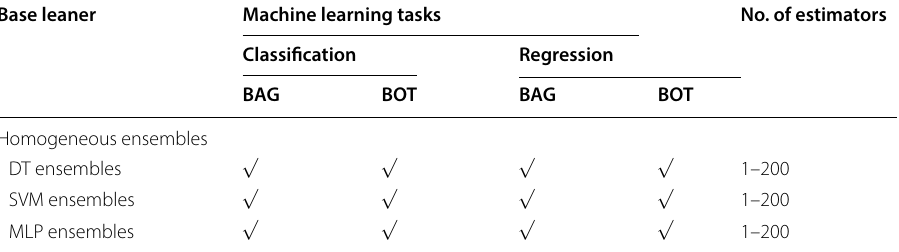
Table 4 Homogeneous ensemble classifiers and regressors